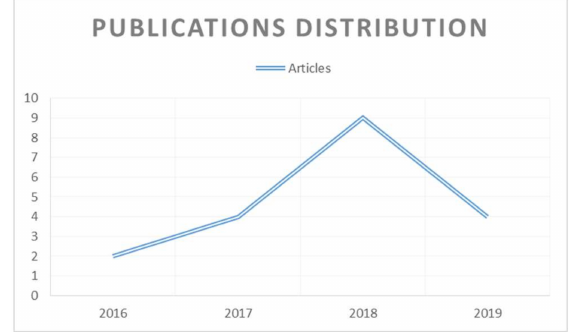
Figure 2. Publications